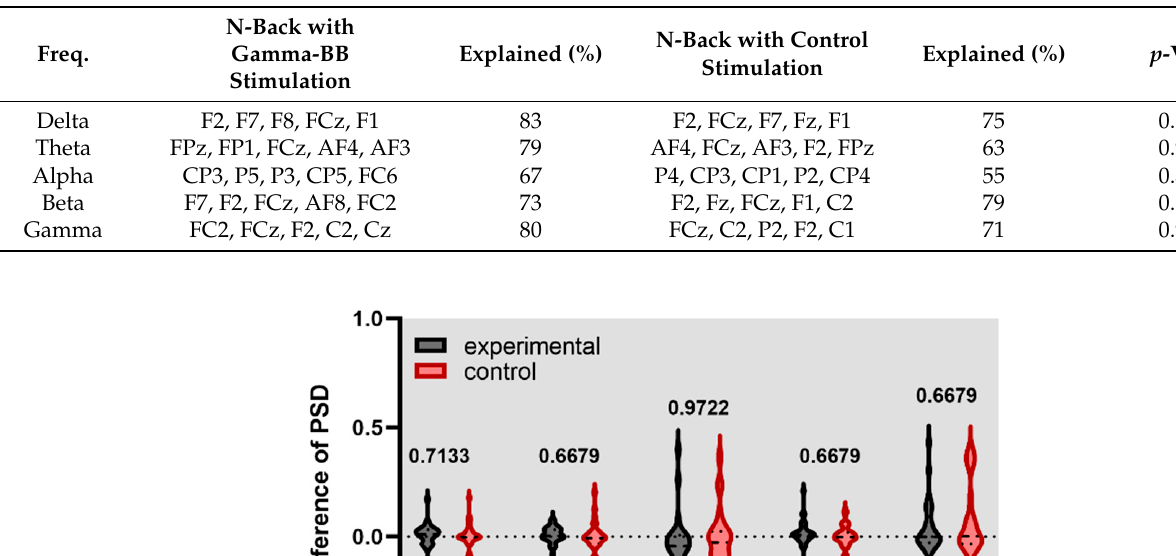
Table 4. The five channels contributed most to the PCA first component, total variance explained by the first component, and p -values for permutation test results for experimental and control stimulation during the n-back task.